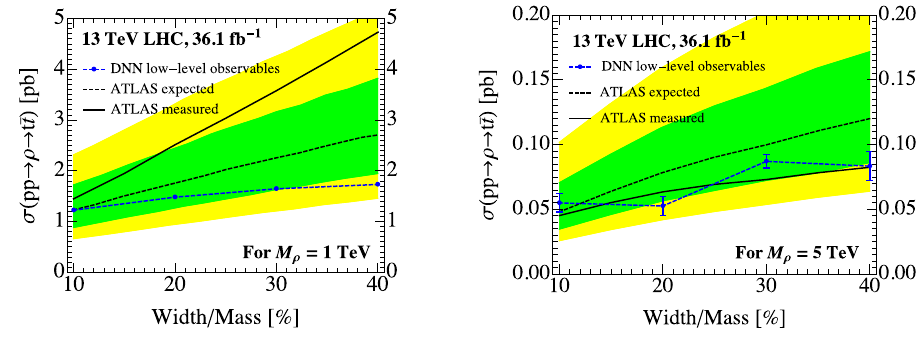
Fig. 3 The DNN-improved cross section upper limits at 95% C.L., obtained by fitting DNN output r distributions in Fig. 2. The latest ATLAS results [7] are also shown for comparison. The vertical error bars of the DNN results are training uncertainties, which are derived by running the same network for 15